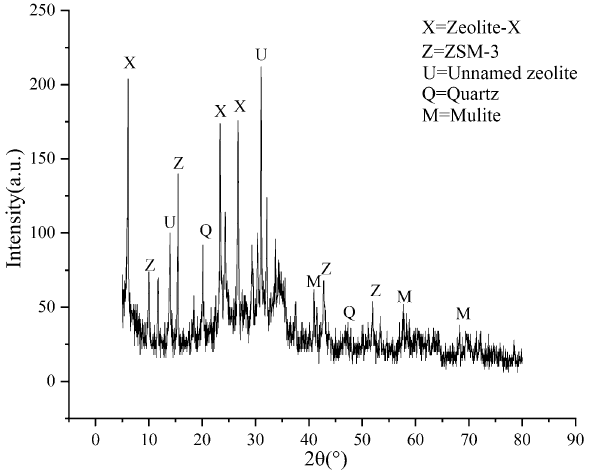
Figure 8. XRD pattern of zeolite synthesized from fly ash.